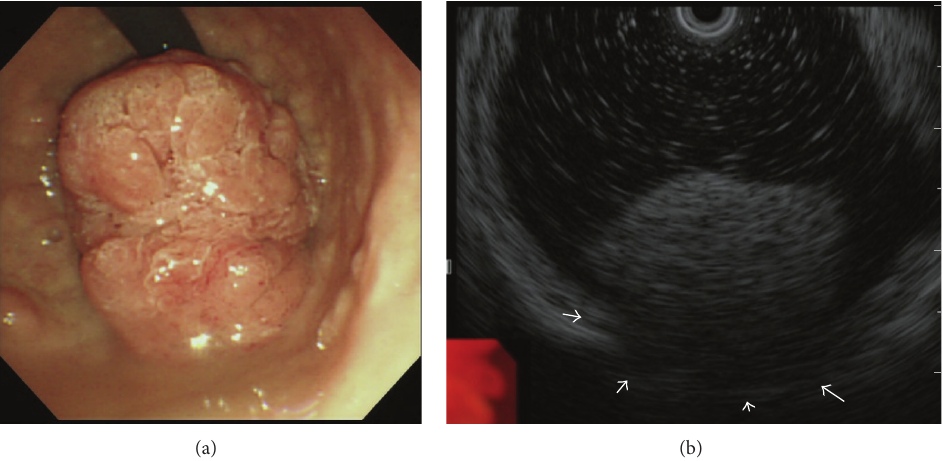
Figure 1: (a) Upper gastric endoscopy revealing a giant polypoid-type tumor extending from the duodenum bulb to the pyloric ring. (b) An endoscopic ultrasound test suggesting that the tumor might invade the muscular tunic (white arrows).